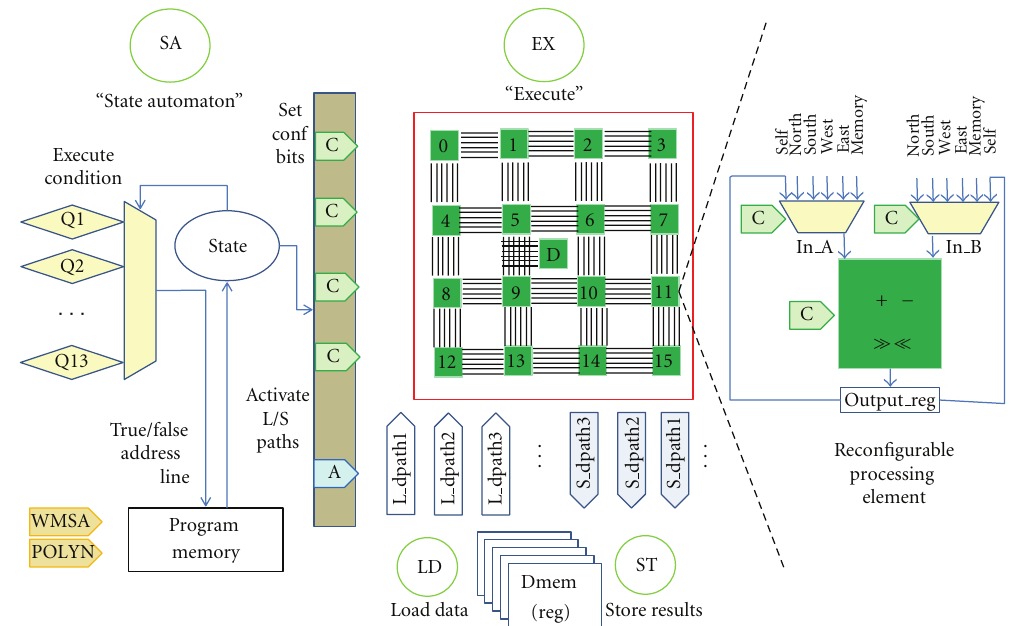
Figure 10: The coarse-grained reconfigurable core-based flexible architecture: 2-stage main pipeline with SA and EX, 4 × 4 reconfigurable core with mesh interconnect, and a zoom-in to one of the elements of the